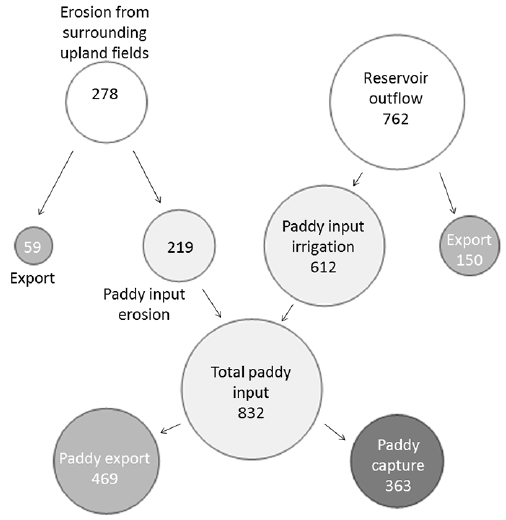
Figure 6. Sediment flow chart for 2011. Bubble size corresponds to size of the sediment load (inMga − 1 )